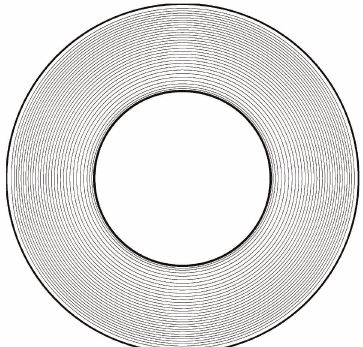
Figure 4: Distribution of the contours of stream function for a uniform external magnetic fluid of Ha (cid:8) 30 (cid:2)Δ ψ (cid:8) 0 . 0025 (cid:3)